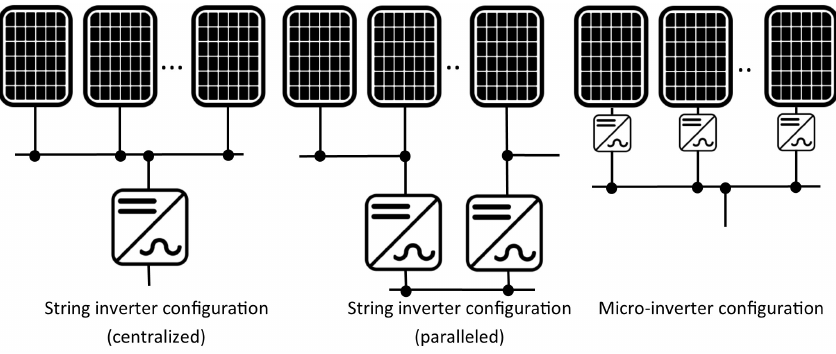
Figure 1. Typical inverter configurations for a rooftop photovoltaic (PV)